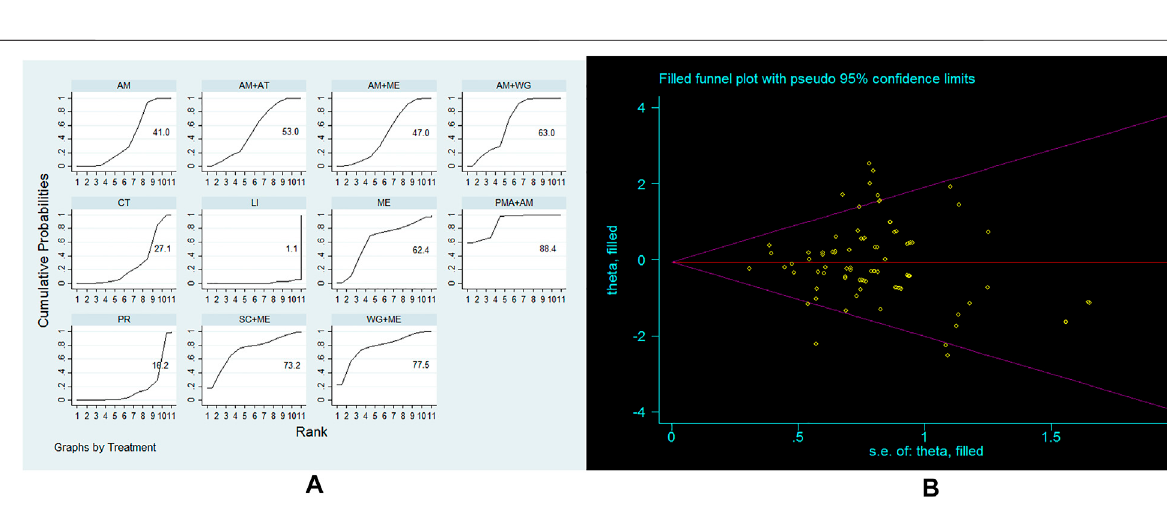
Frontiers in Pharmacology |